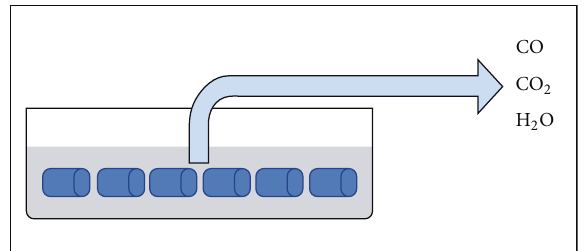
Figure 2: Scheme of sampling the atmosphere from the container.